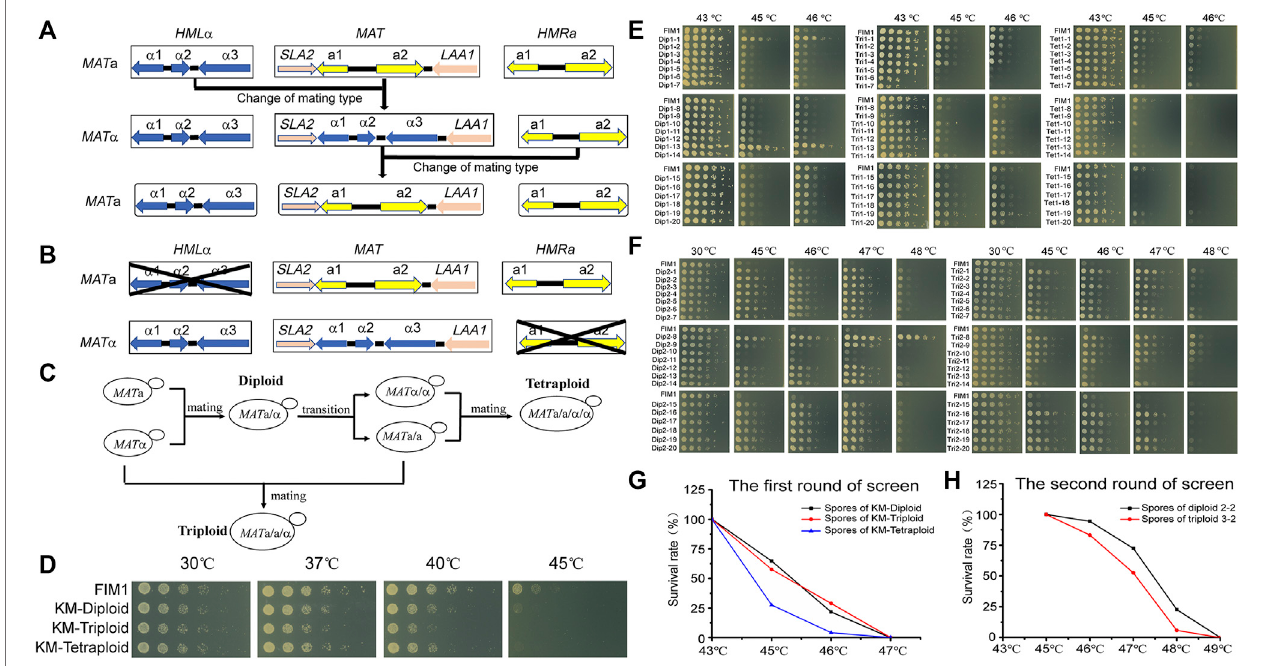
FIGURE 1 | The meiosis-based evolution of the thermotolerance in K. marxianus . (A) Switches of mating type in K. marxianus . (B) Constructions of stable MAT a and MAT α cells. (C) Constructions of diploid, triploid and tetraploid cells. (D) Spot assay of FIM1, KM-Diploid, KM-Triploid and KM-Tetraploid strains at different temperatures. (E) Spot assay of spores generated by KM-Diploid, KM-Triploid and KM-Tetraploid at different temperatures. (F) Spot assay of spores generated by 2 – 2 and 3 – 2 at different temperatures. (G, H) Survival rates of spores generated in the fi rst (G) and second (H) rounds of the screen at different